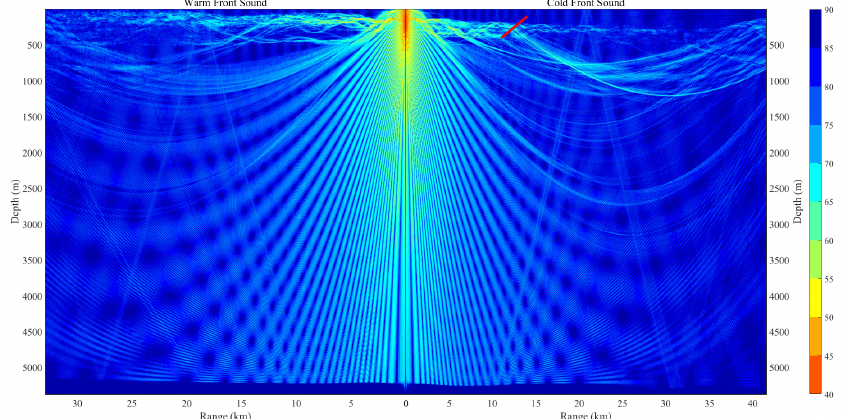
Figure 16. Transmission Loss in both warm and cold sides of oceanic